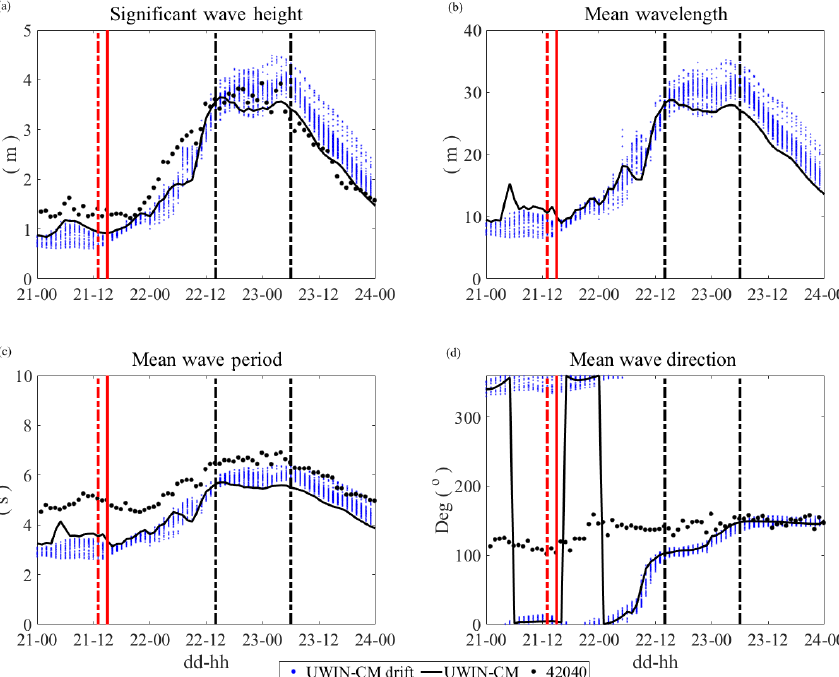
Figure 4. Significant wave height (a) , mean wavelength (b) , mean wave period (c) and mean wave direction (d) from the UWIN-CM and NDBC buoy 42040 during the January high wind event. Dashed vertical black lines show the beginning and end of the high wind analysis periods. Dashed (solid) red lines indicate beginning of the hour over which the pre-existing regional circulation was estimated with undrogued (drogued) drifters. Wave data from the UWIN-CM, plotted at the nearest point to every drifter location, are shown in blue. The solid black lines show the UWIN-CM output data closest to the coordinates of buoy 42040, while observations from buoy 42040 are shown with black dots. Wavelength data were not collected by this NDBC